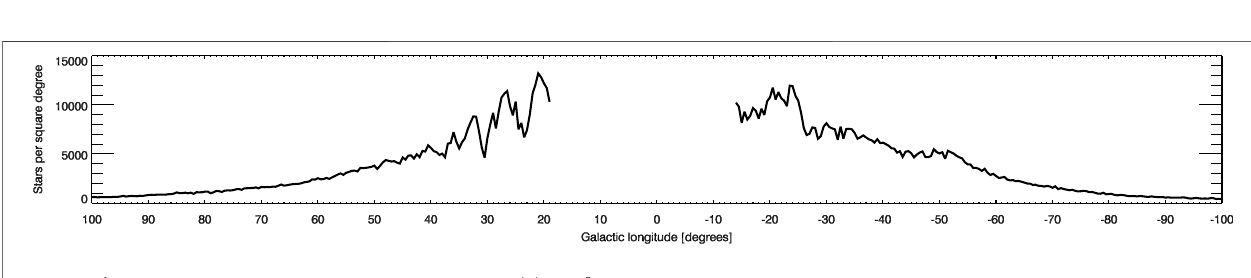
FIGURE 2 | Longitudinal pro fi les (counts up to K 0 (cid:1) 11.5 mag) for | b | ≤ 0.5 o .